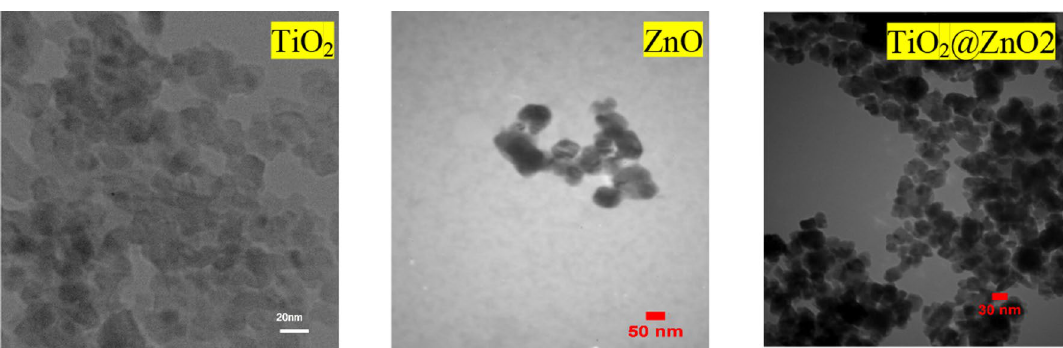
Figure 3. TEM of TiO 2 quantum dots, ZnO quantum dots and TiO 2 @ZnO